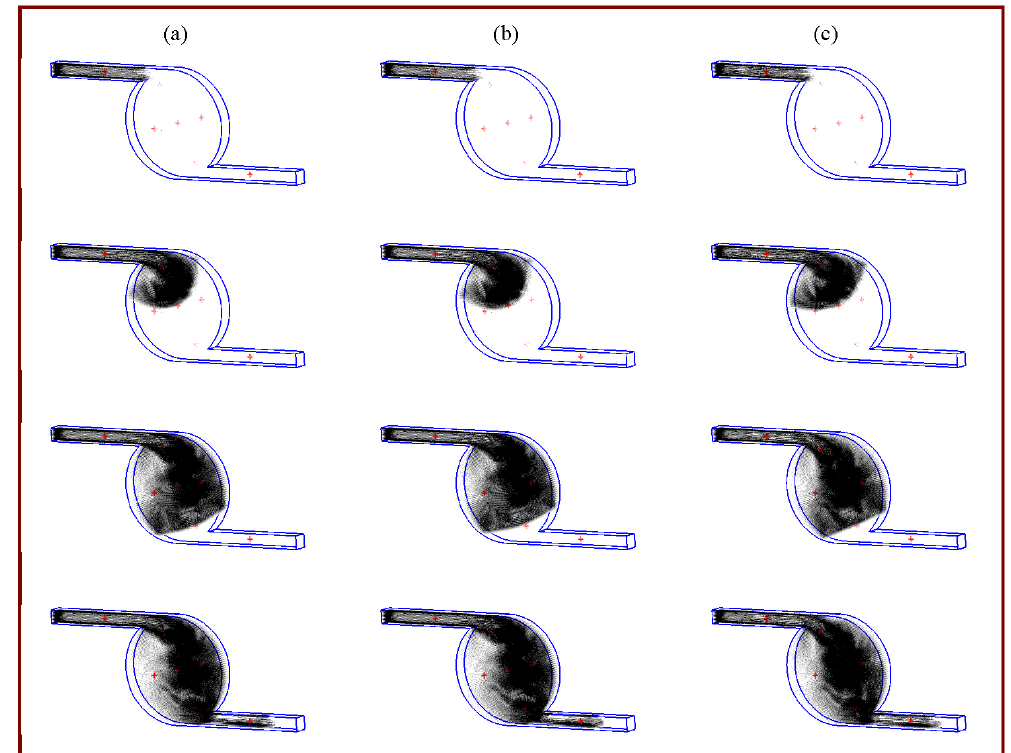
Figure 7. Filling process for three models: ( a ) single ramp model; ( b ) stretched hyperbolic tangent model; and ( c ) quadratic